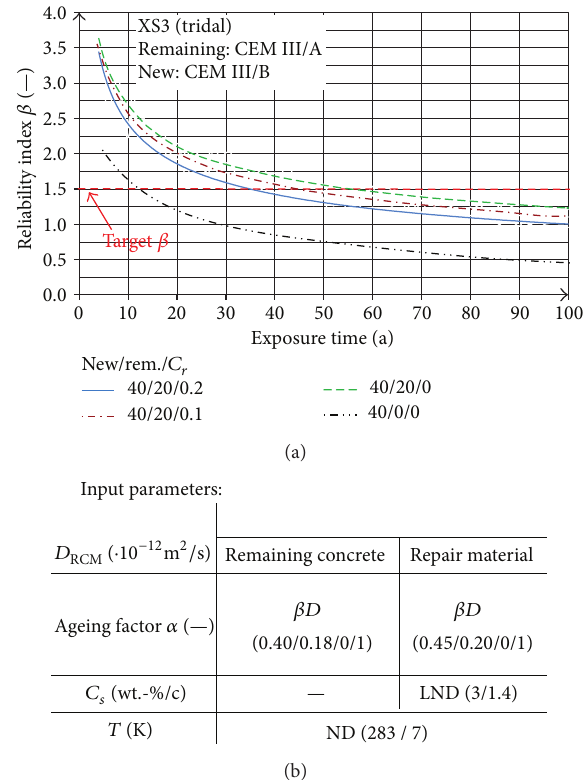
Figure 7: Estimated corrosion initiation time after application of a repair